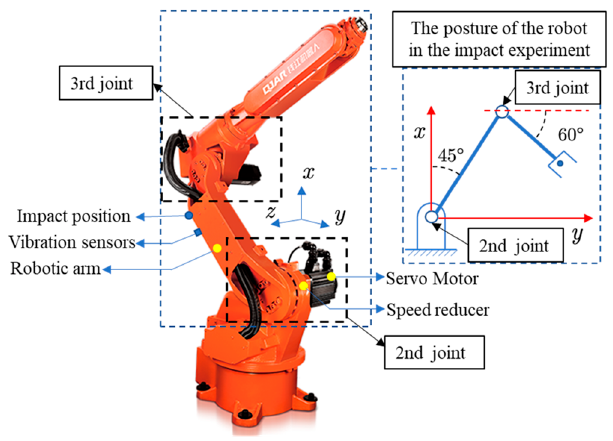
Figure 16. Six-degree-of-freedom industrial robots.